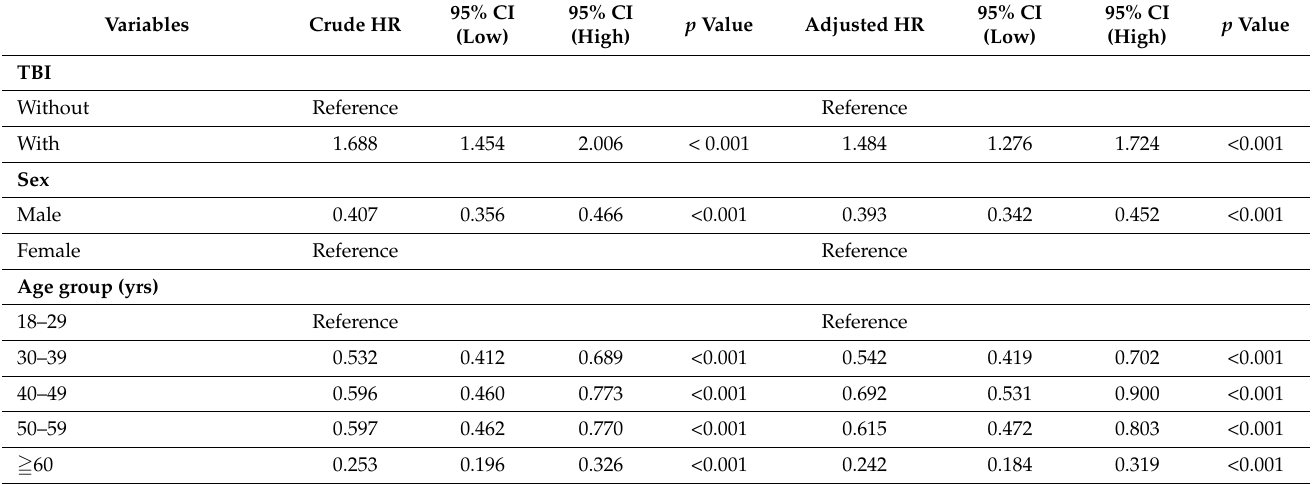
Table A3. Factors associated with migraine by the end of follow-up in the Cox regression